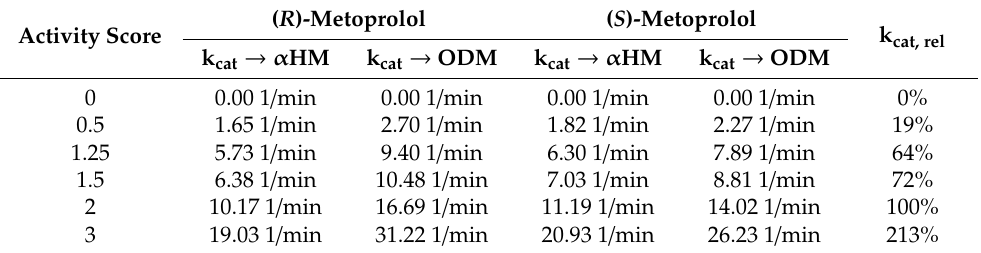
Table 3. Optimized k cat, rel values for the di ff erent modeled CYP2D6 activity scores. ( R )-Metoprolol ( S Activity Score